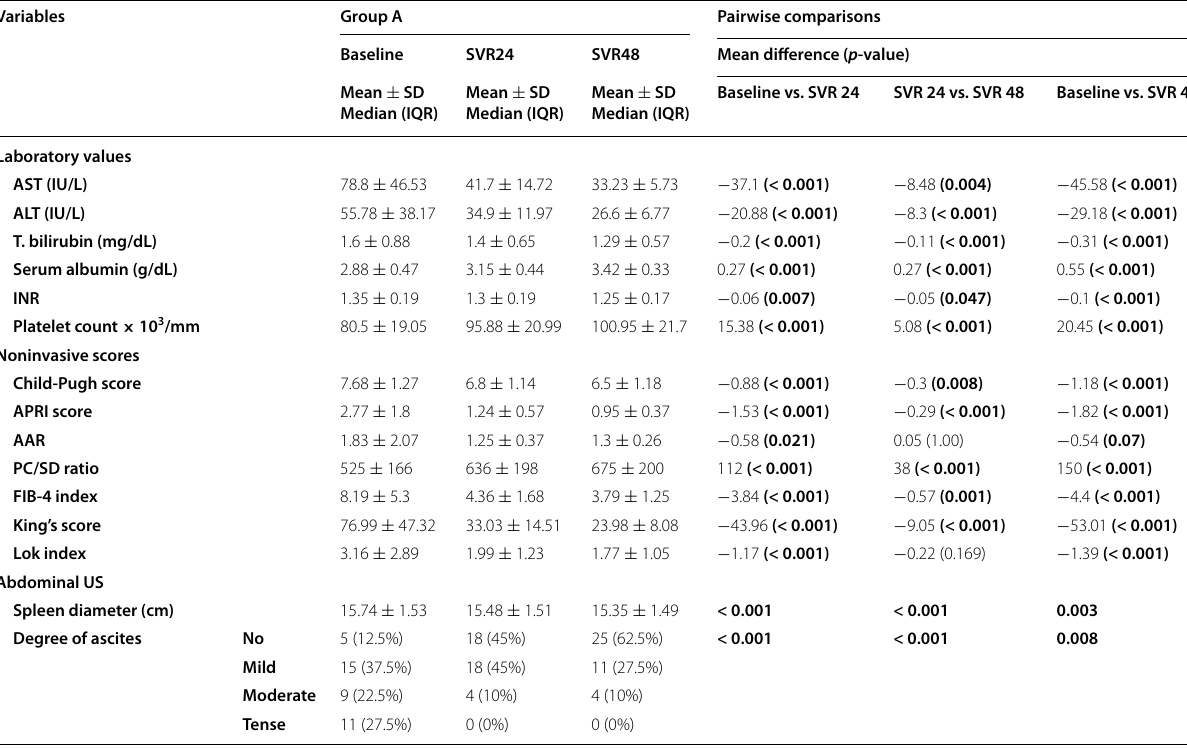
Table 3 Pairwise comparison between baseline, SVR 24, and SVR 48 at group A regarding labs, scores, and abdominal